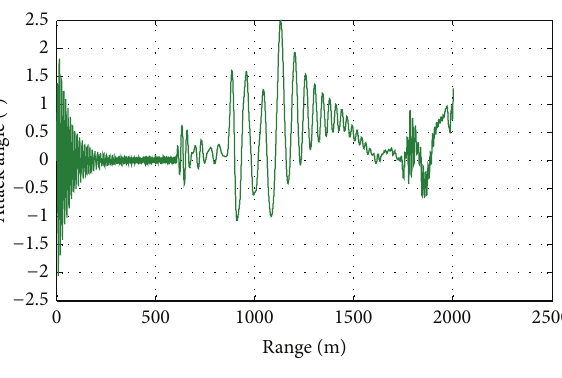
Figure 15: Attack angle.